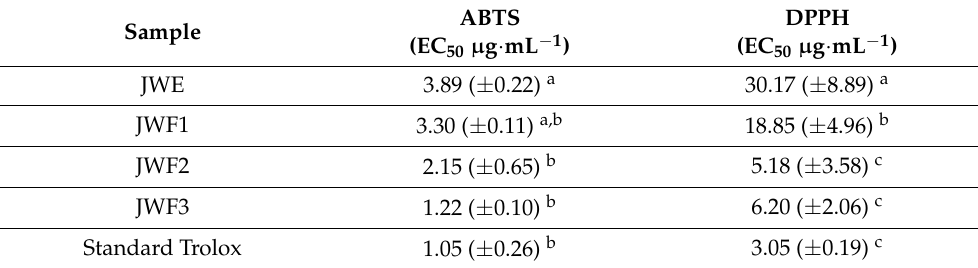
Table 2. Antioxidant capacity of jabuticaba wine extract (JWE) and fractions (JWF1–JWF3).